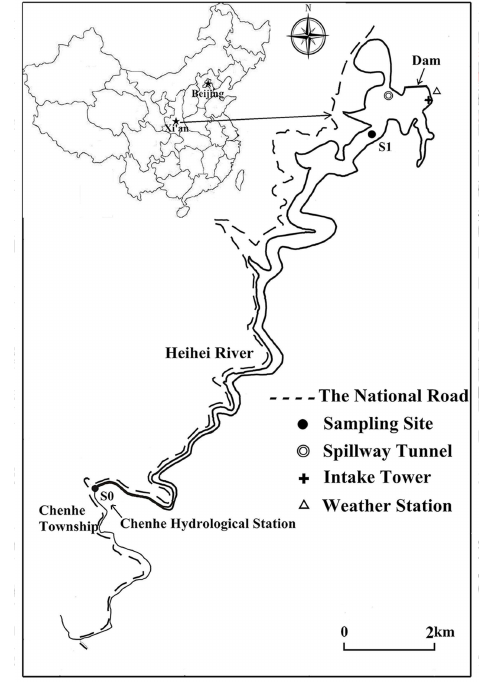
Figure 1. Location of Heihe Reservoir and the sampling sites.